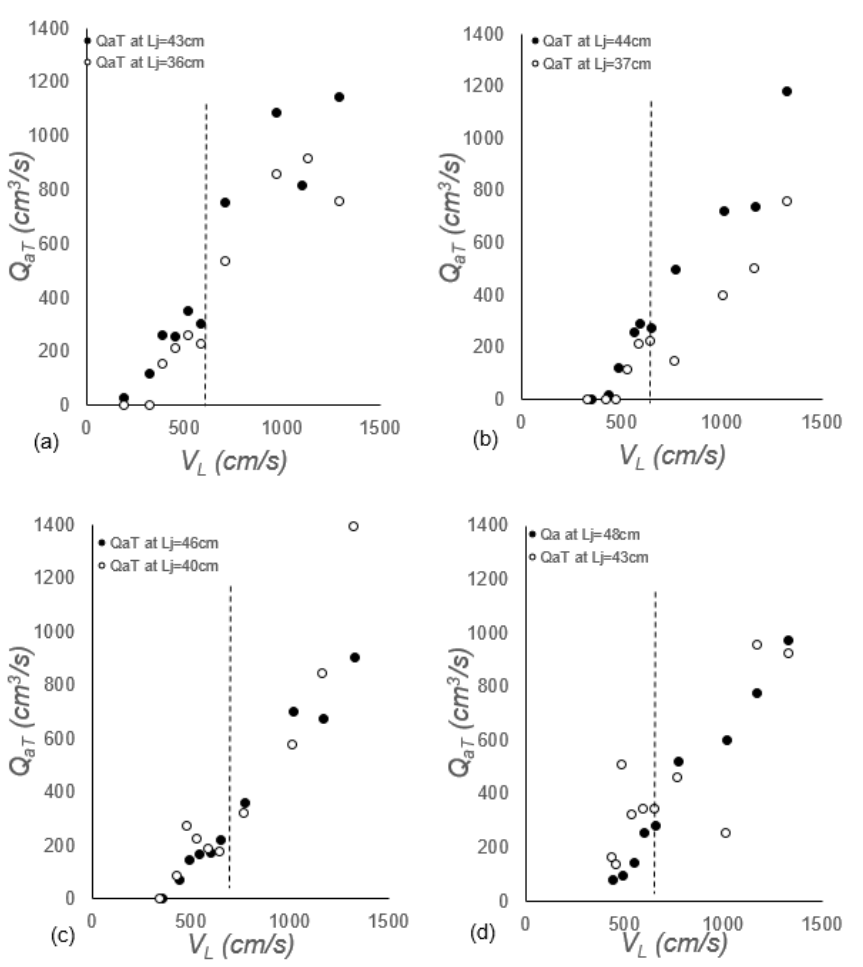
Water 2023 , 15 , x FOR PEER REVIEW 14 of 20